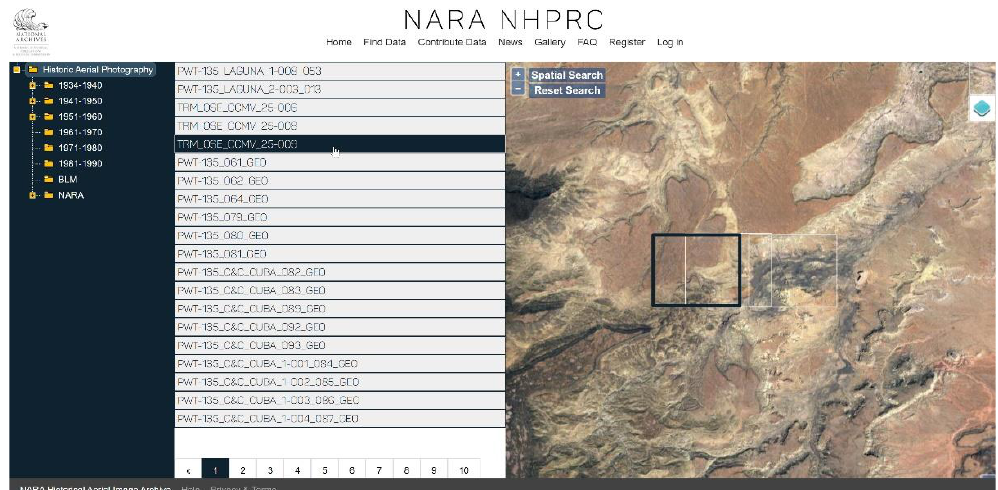
Figure 4. The user interface of the bounding box display tool. The middle panel lists all web- published historical aerial photos. When a photo is selected (highlighted with a dark blue bar) in middle listing panel, its matching bounding box will be highlighted with a dark blue rectangular box in the mapping panel on the right side, indicating the selected photo’s ground location and coverage.